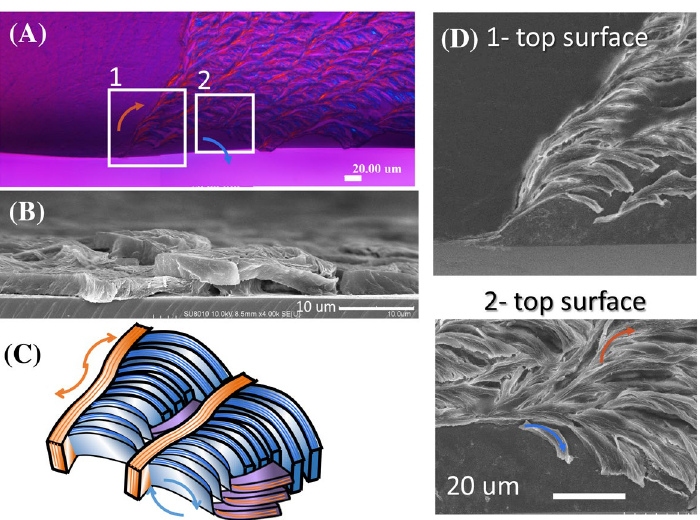
Figure 9. Dendrite PLLA spherulite showing three geometries of lamellae species: ( A ) POM graph showing birefringence patterns in solvent-etched sector-face PLLA spherulites, ( B ) SEM micrograph, ( C ) scheme for two dominant lamellae orientations to form cross-hatch patterns, and ( D ) top-view of radial vs. tangential lamellae in